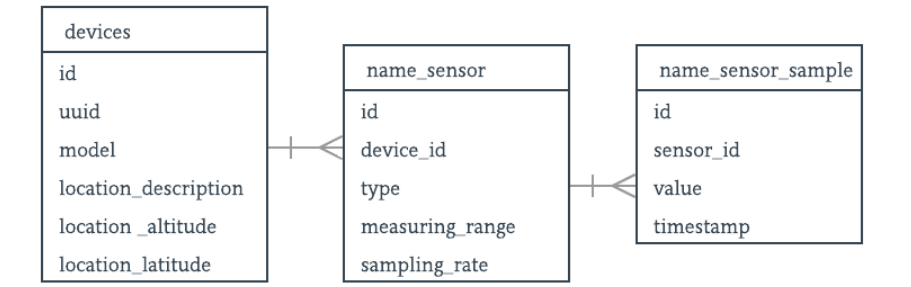
Figure 1. Basic data structure of the extended architecture of